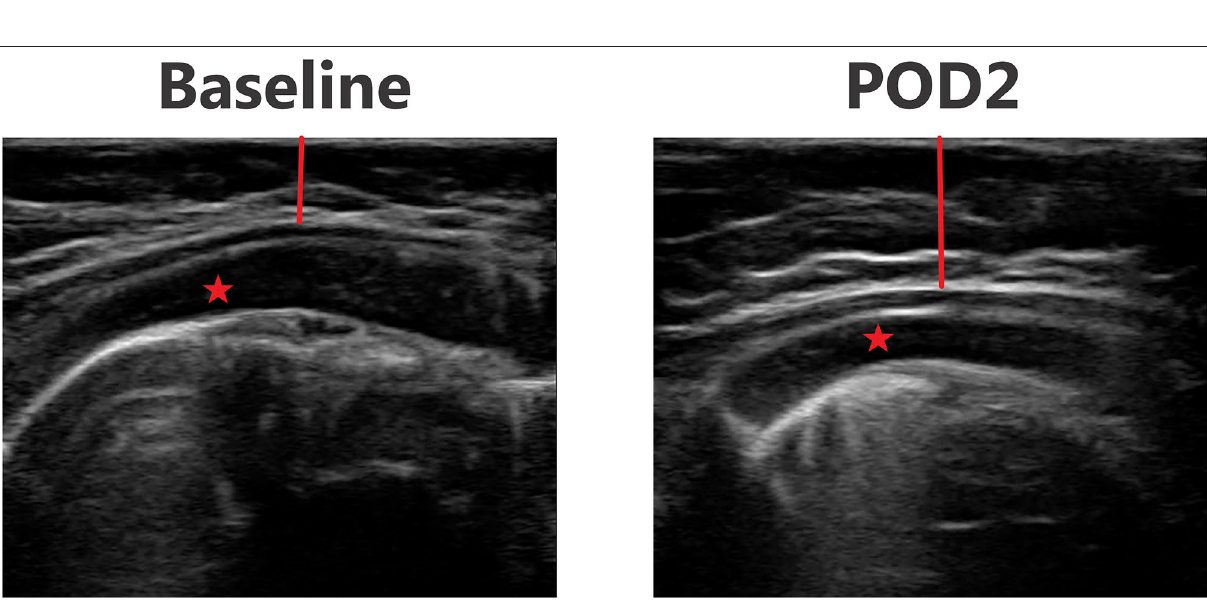
FIGURE 3 | Point-of-care ultrasound images of anterior chest at baseline and POD 2 of the same patient. Both images are presented on identical scales (total depth of 2.5cm from the skin). Red vertical line demonstrates subcutaneous tissue thickness—there is a marked increase in subcutaneous tissue seen on POD 2. Red star—pectoralis major